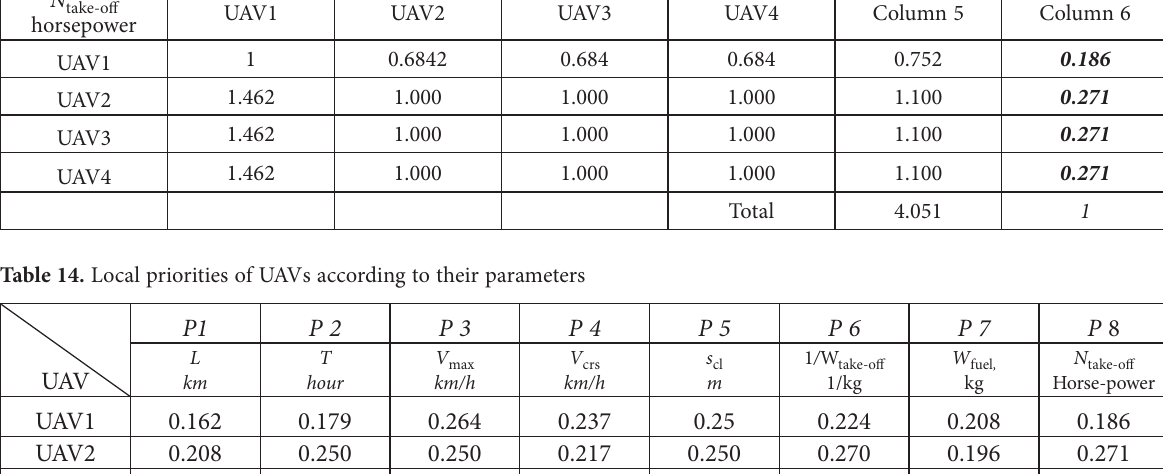
Table 13. Matrix of take-off power N take-off horsepower